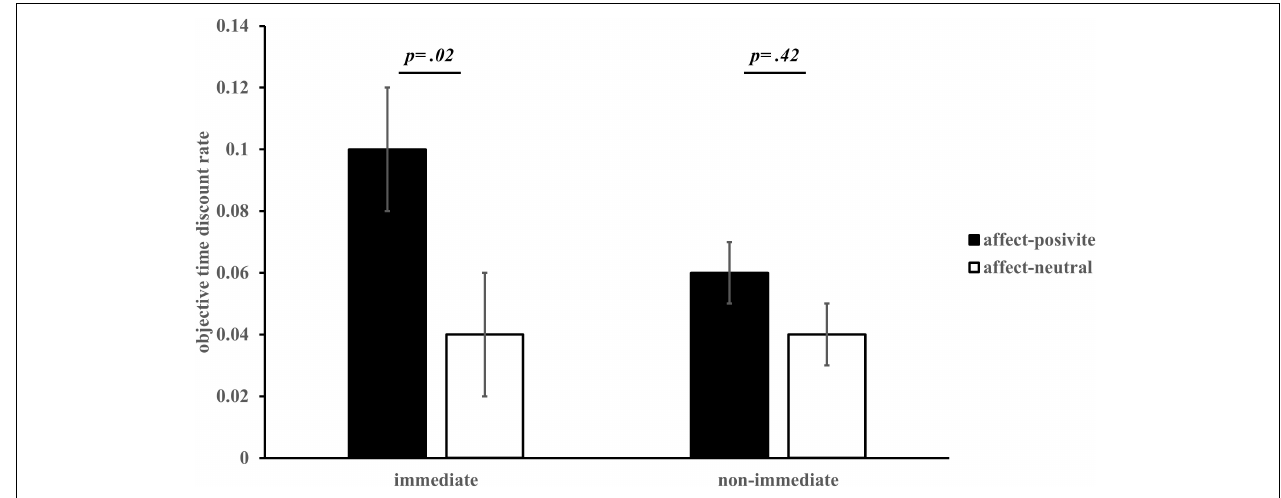
FIGURE 3 | Objective time discount rate for different affect groups (M ± SE)